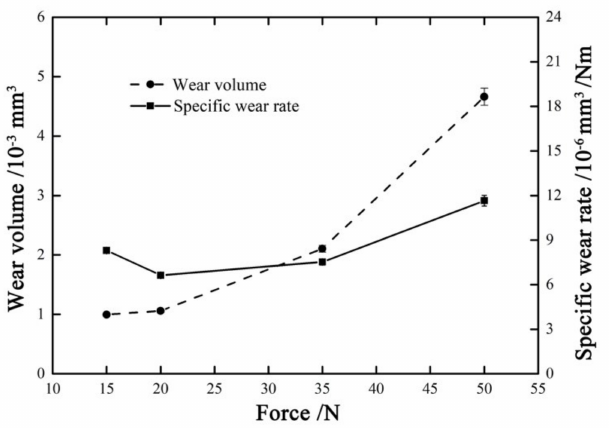
Figure 18. Wear volume and specific wear rate versus normal force with ƒ = 15 Hz, D = ± 20 µ m, and V c = 0